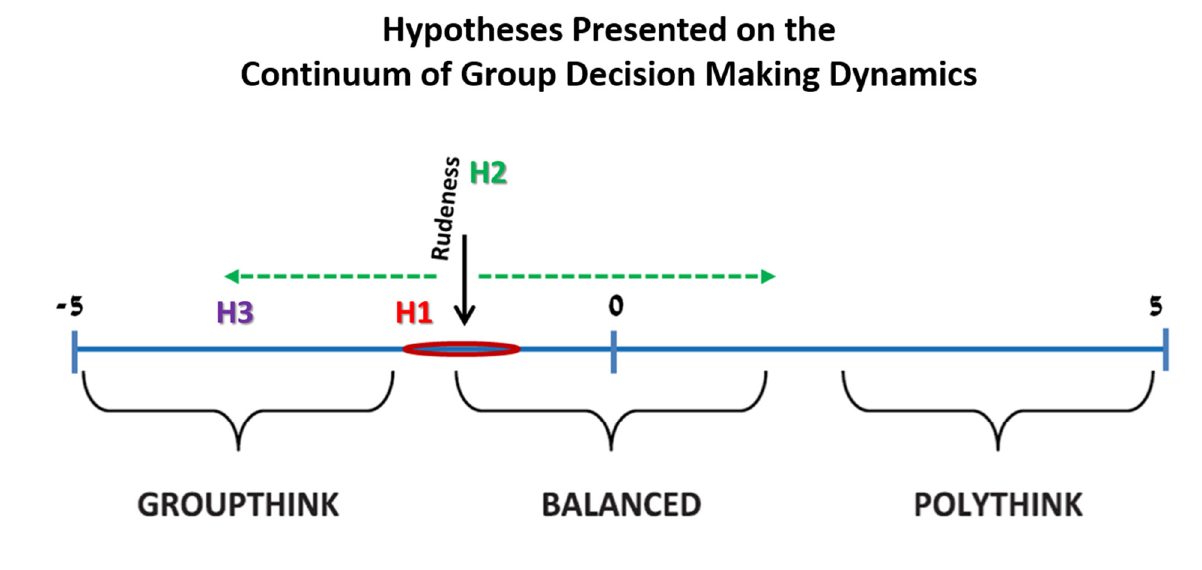
Figure 1. Hypotheses presented on the continuum of group decision-making dynamics. Adapted from Mintz A & Wayne C (2016) [8]. The Polythink Syndrome: US Foreign Policy Decisions on 9/11, Afghanistan, Iraq, Iran, Syria and ISIS. Stanford, California: Stanford University Press with permis- sion.